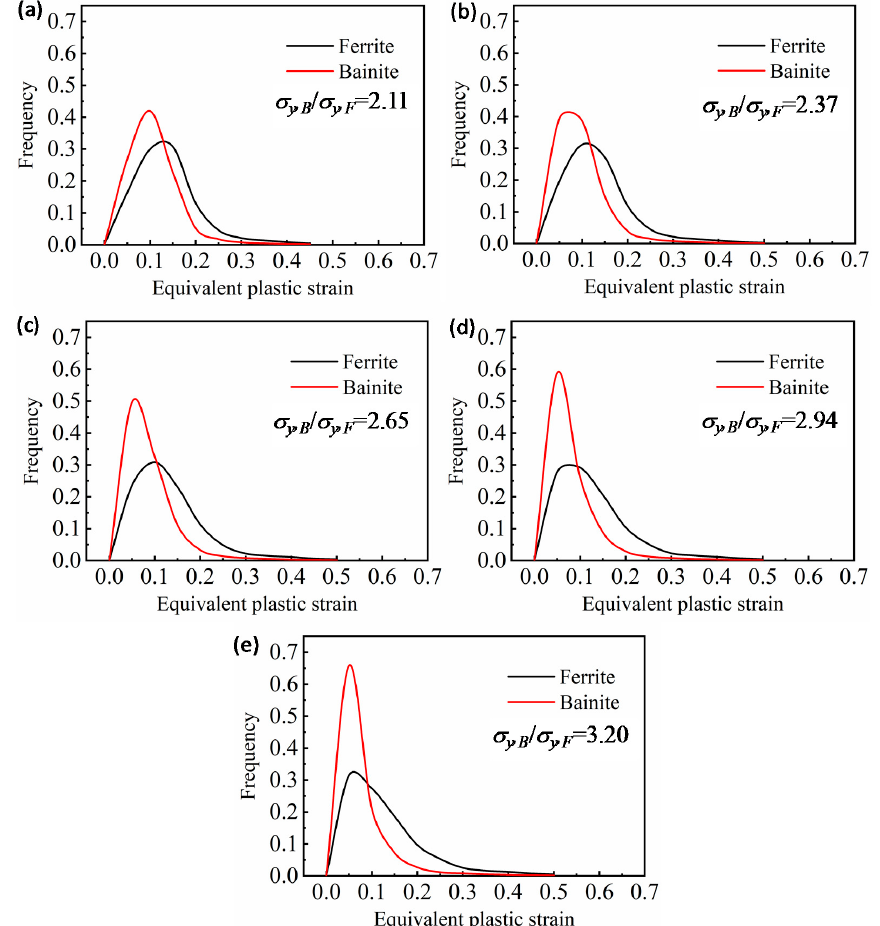
Figure 6. PDF curves of equivalent plastic strains of ferrite and bainite in the model with σ y , B / σ y , F of ( a ) 2.11, ( b ) 2.37, ( c ) 2.65, ( d ) 2.94, and ( e ) 3.20.